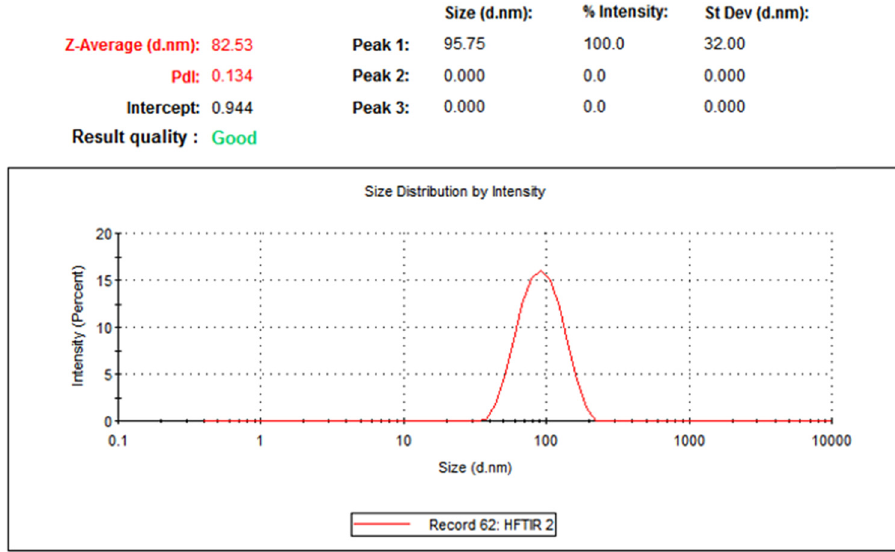
Figure 4: DLS measurement of the average size of phytosynthesized Ag - NPs.